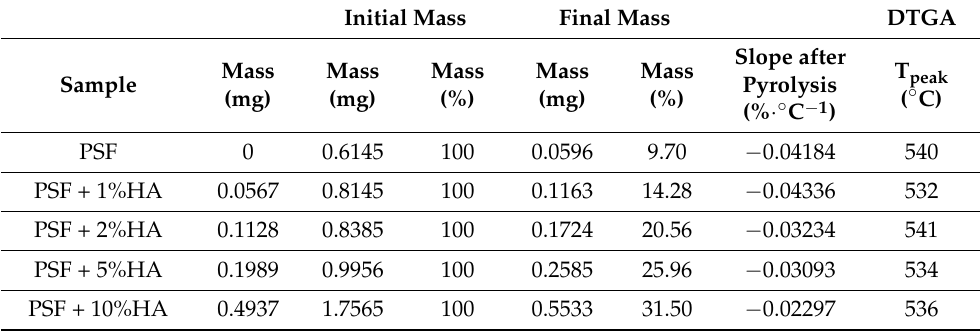
Table 3. Parameters obtained from TGA and DTGA curves (initial mass, residual mass, slope after pyrolysis, and peak temperature, T p ).